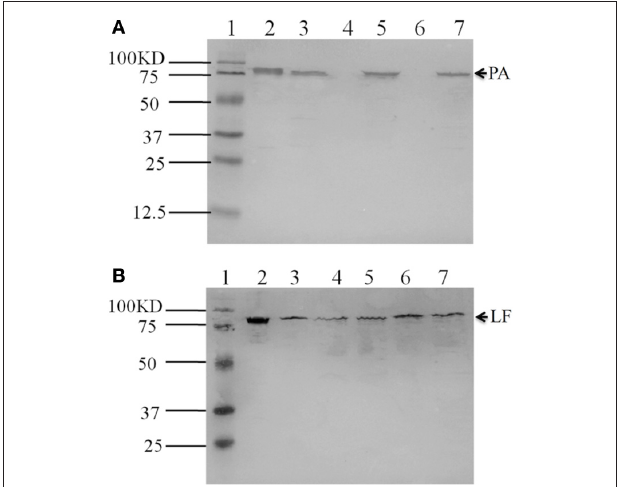
FIGURE 2 | Western blot detection of PA and LF expressed in variant strains. PA was detected by hybridization with anti-PA antibody (A) . Lane 1, protein molecular size marker; Lane 2, control PA (100 ng); Lane 3, Pasteur II; Lane 4, PasteurII-pag promoter-KO strain; Lane 5, PasteurII-pag promoter-KO-CO strain; Lane 6, PasteurII-pagKO strain; Lane 7, PasteurII-pagKO-CO strain. LF was detected by hybridization with anti-LF antibody (B) . Lane 1, protein molecular size marker; Lane 2, control LF (100 ng); Lane 3, Pasteur II; Lane 4, PasteurII-pag promoter-KO strain; Lane 5, PasteurII-pag promoter-KO-CO strain; Lane 6, PasteurII-pagKO strain; Lane 7, PasteurII-pagKO-CO